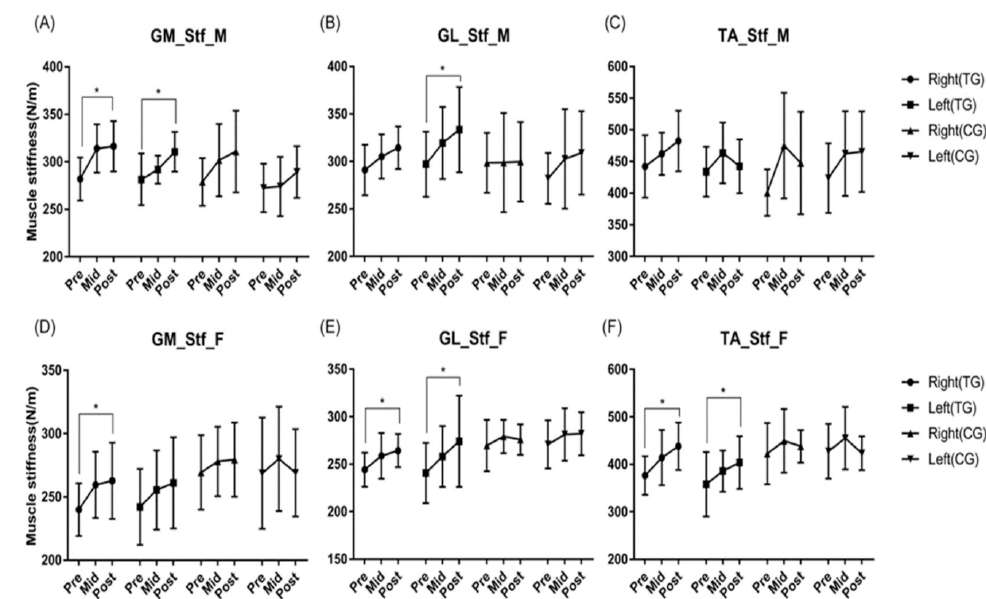
Figure 4. Effects of core balance training on muscle stiffness. There was a difference in muscle